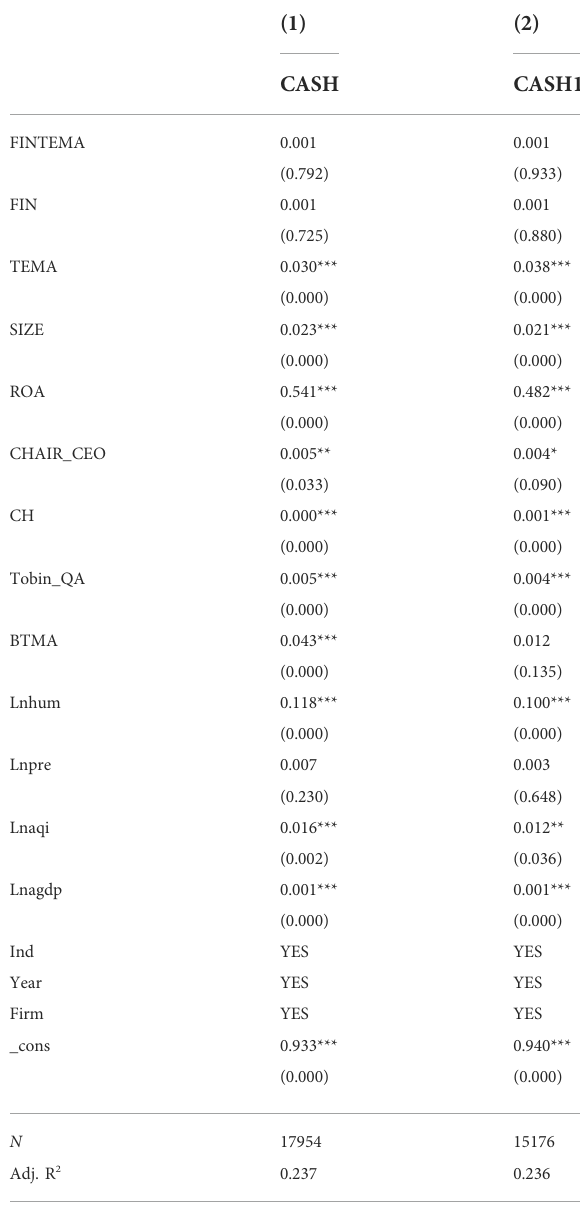
TABLE 10 Financial risk mechanism